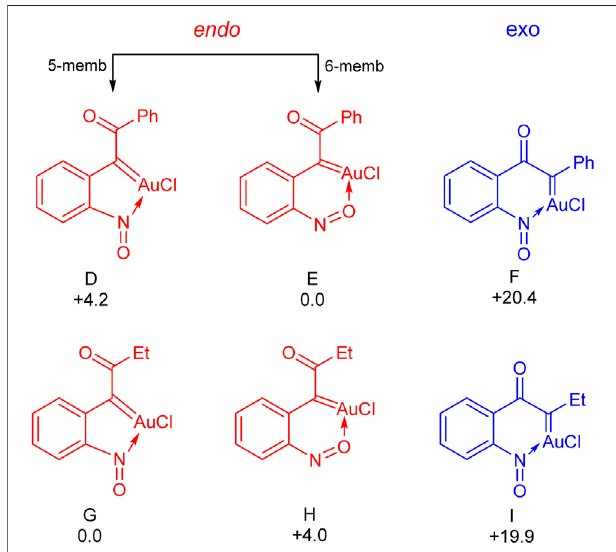
FIGURE 1 | The relative free energies of α -oxo gold carbenes with respecttothemoststableone(EforthephenylsubstitutionandGfortheethyl substitution). Values are in